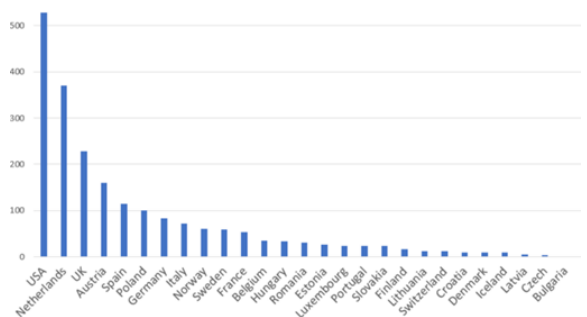
Fig. 1. The size of e-bus fleet in European region and USA